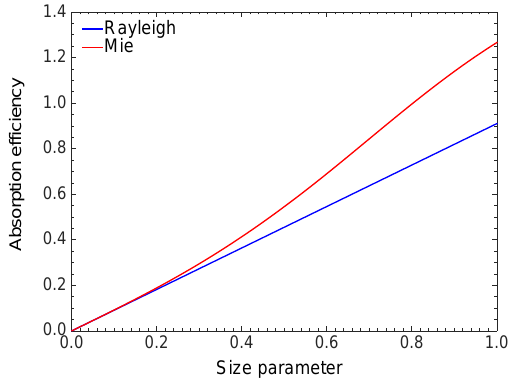
Figure 1. Comparison of the Rayleigh approximation and Mie the- ory for the absorption efficiency of spheres with a refractive index of 1.8 + 0.6 i